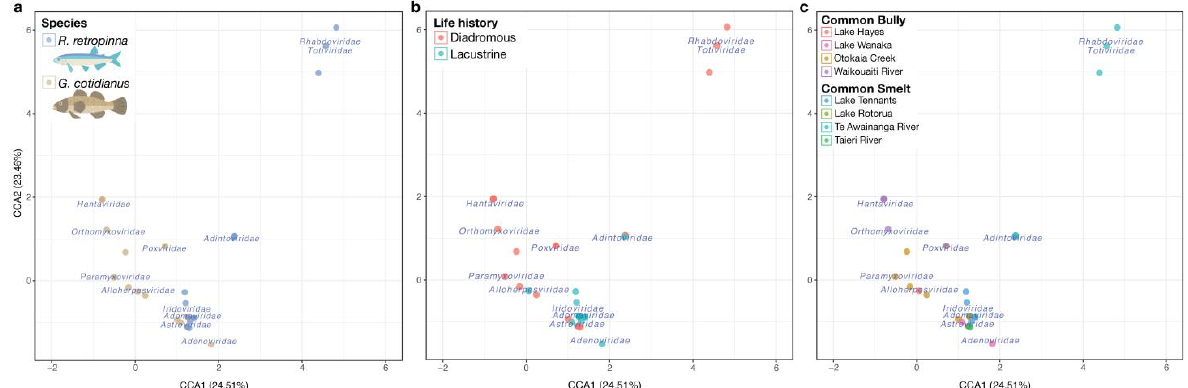
Figure 6. ( a ) Constrained correspondence analysis of vertebrate-associated viral diversity with sample fish species indicated in blue for R. retropinna and beige for G. cotidianus . ( b ) Constrained correspondence analysis of vertebrate-associated viral diversity with fish life history indicated in pink for diadromous fish and blue for lacustrine fish. ( c ) Constrained correspondence analysis of vertebrate-associated viral diversity with fish source population indicated. Viral taxonomic family centroids indicated in blue text.